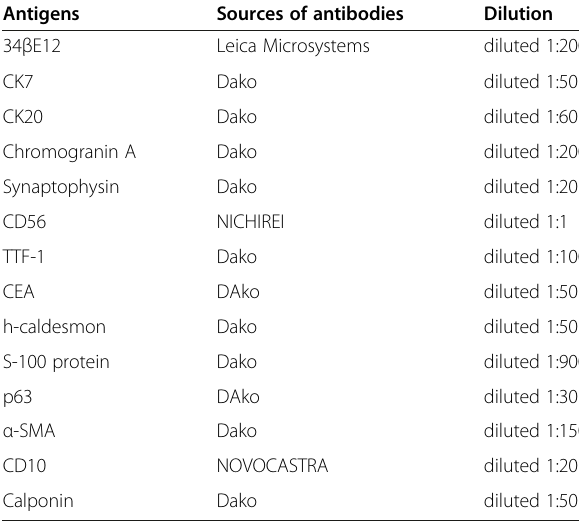
Table 1 The profile of all immunohistochemical antigens Antigens Sources of antibodies